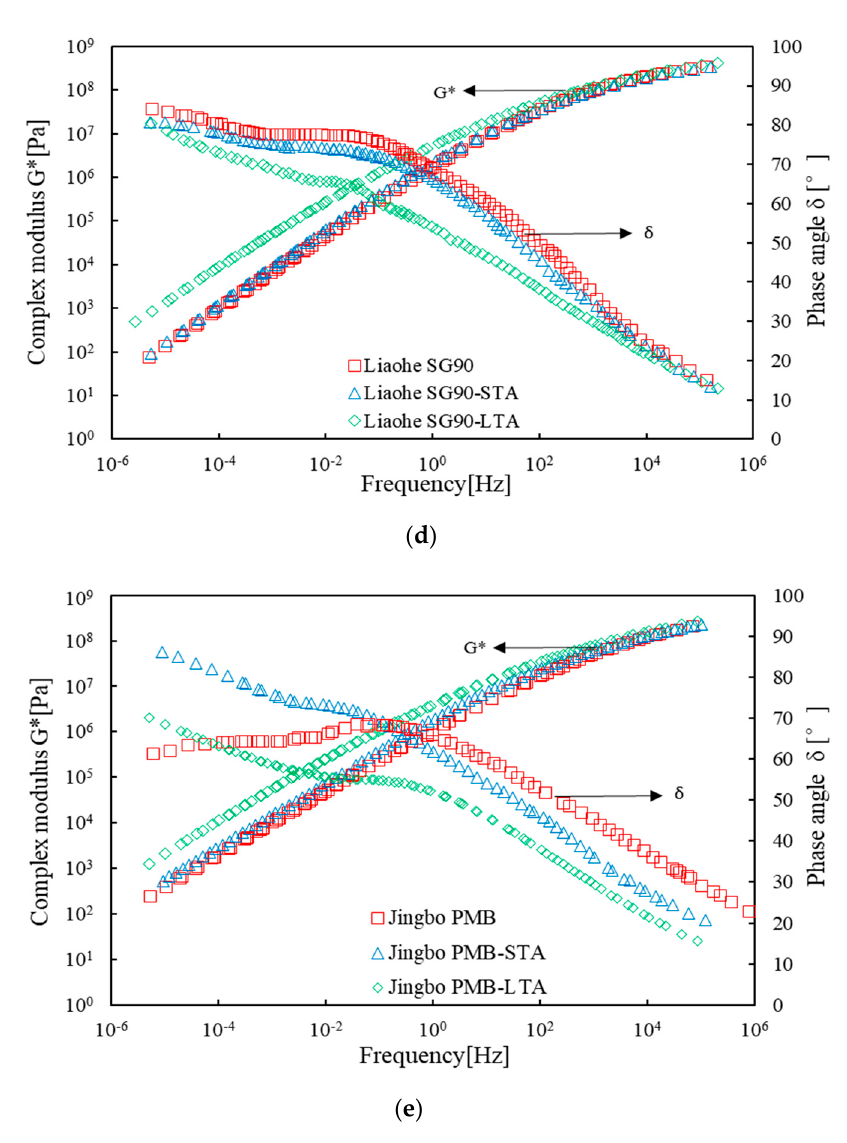
Figure 3. Master curves of complex modulus and phase angle of unaged, short- and long-term aged bitumen binders: ( a ) Karamay SG70; ( b ) Jingbo SG70; ( c ) Jurong SG90; ( d ) Liaohe SG90; ( e ) Jingbo PMB.